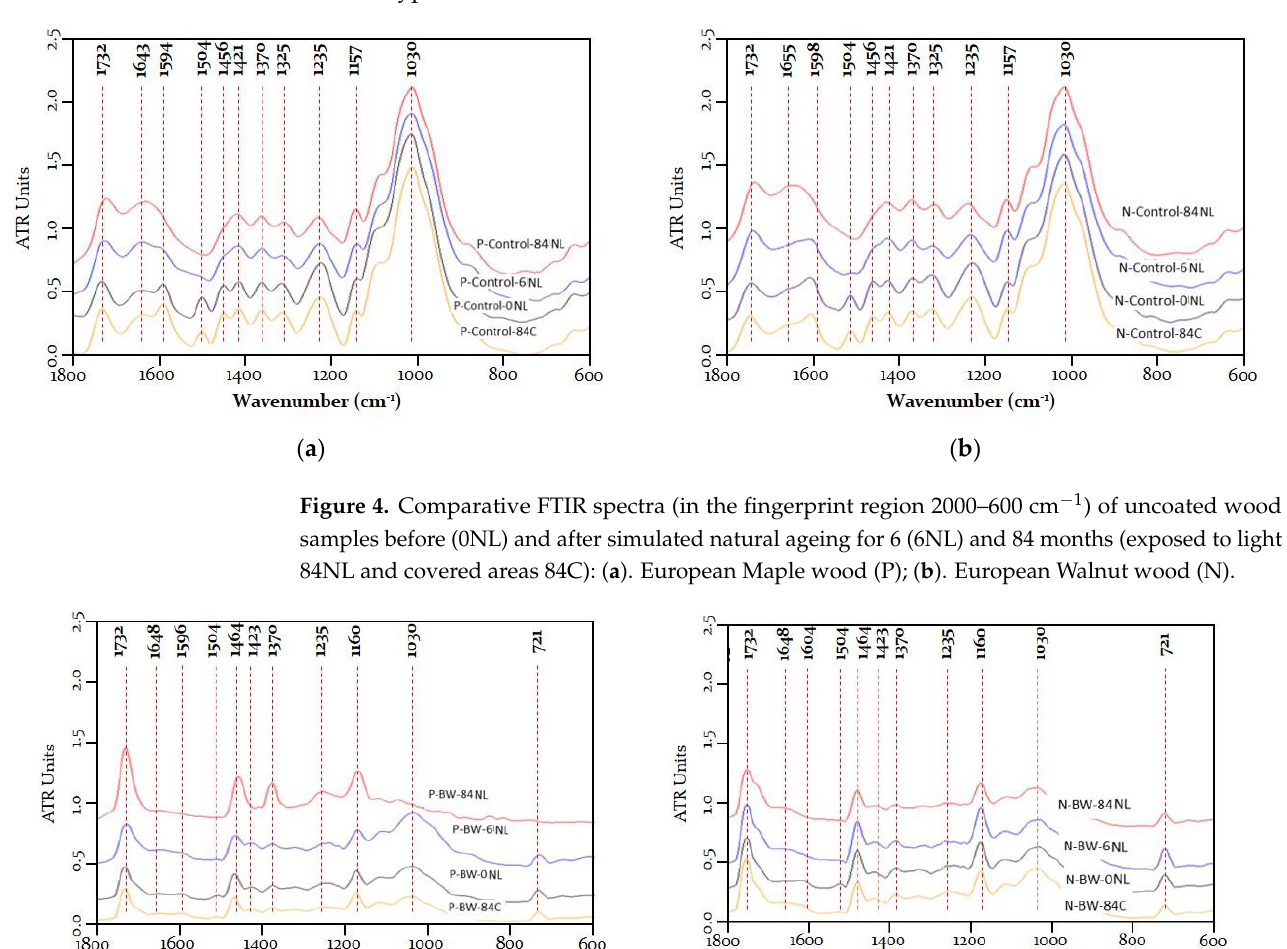
( b ) Figure 6. Comparative FTIR spectra (in the fingerprint region 2000 – 600 cm −1 ) of wood samples coated with Chinese wax (CW) before and after simulated natural ageing for 6 (6UV) and 84 months (exposed 84UV and covered areas 84C): ( a ). European Maple wood (P); ( b ). European Walnut wood (N). For both types of uncoated wood samples, the FTIR spectra clearly highlighted im- portant chemical changes due to light-induced natural ageing, revealed by changes in some of the specific absorption bands of the main wood components. These changes were visible after 6 months of exposure and evolved after 84 months. The most evident modi- fications were the decrease up to complete disappearance of the lignin-associated bands at around 1504 cm − 1 and 1594 cm − 1 , assigned to lignin C=C stretching vibrations of the aromatic rings [35]. They occurred in parallel with increase of the absorption intensity of the bands at around 1732 cm − 1 , assigned to unconjugated carbonyl groups and that at around 1643 cm − 1 , assigned to conjugated and aromatic carbonyls, which also slightly shifted to lower values after 84 months. These carbonyl peaks may be associated with chromophores resulting from lignin photo-degradation. Additionally, it could be noticed the decrease of the peak at around 1235 cm − 1 , assigned to syringyl ring and C – O stretch in lignin and xylan [61], and an increase of peaks at around 1157 cm − 1 , assigned to asymmet- ric C – O – C stretching associated with cellulose and hemicelluloses, indicating an apparent increase of cellulose content, mainly due to lignin degradation. These chemical changes